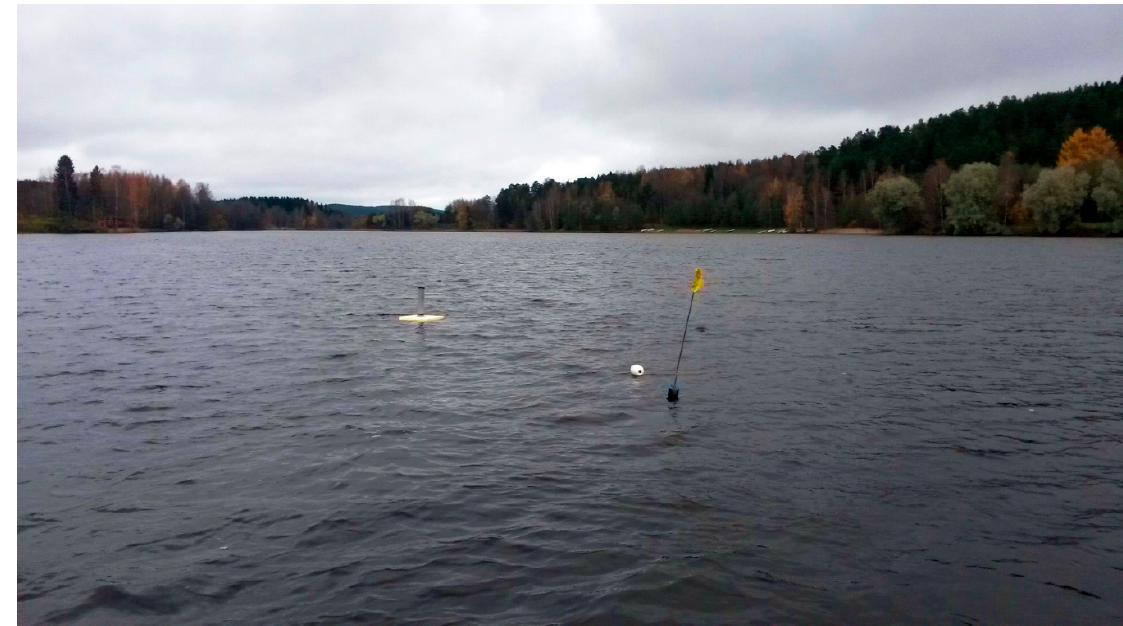
Figure 3. Online trap in Savilahti Bay basin at a depth of 6 m under the flag sign. Anchored float behind flag sign is the base station for the online trap, which sends measurements to the Internet over a mobile network.